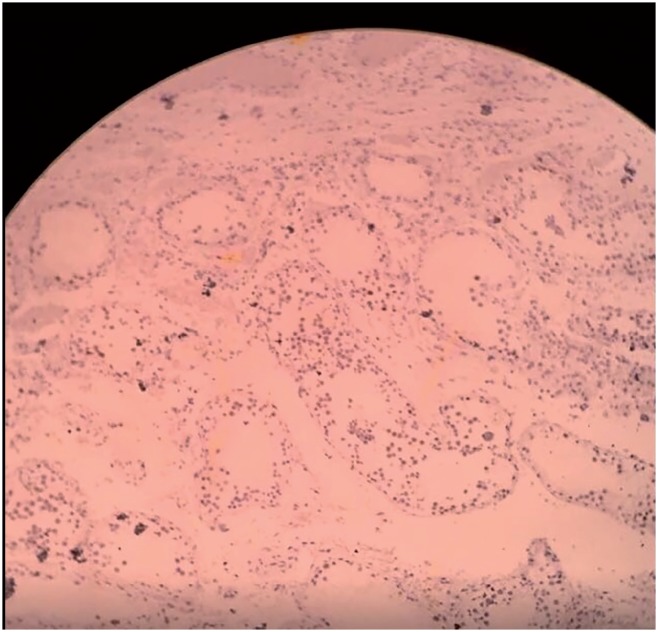
CD117 antibody (4x).